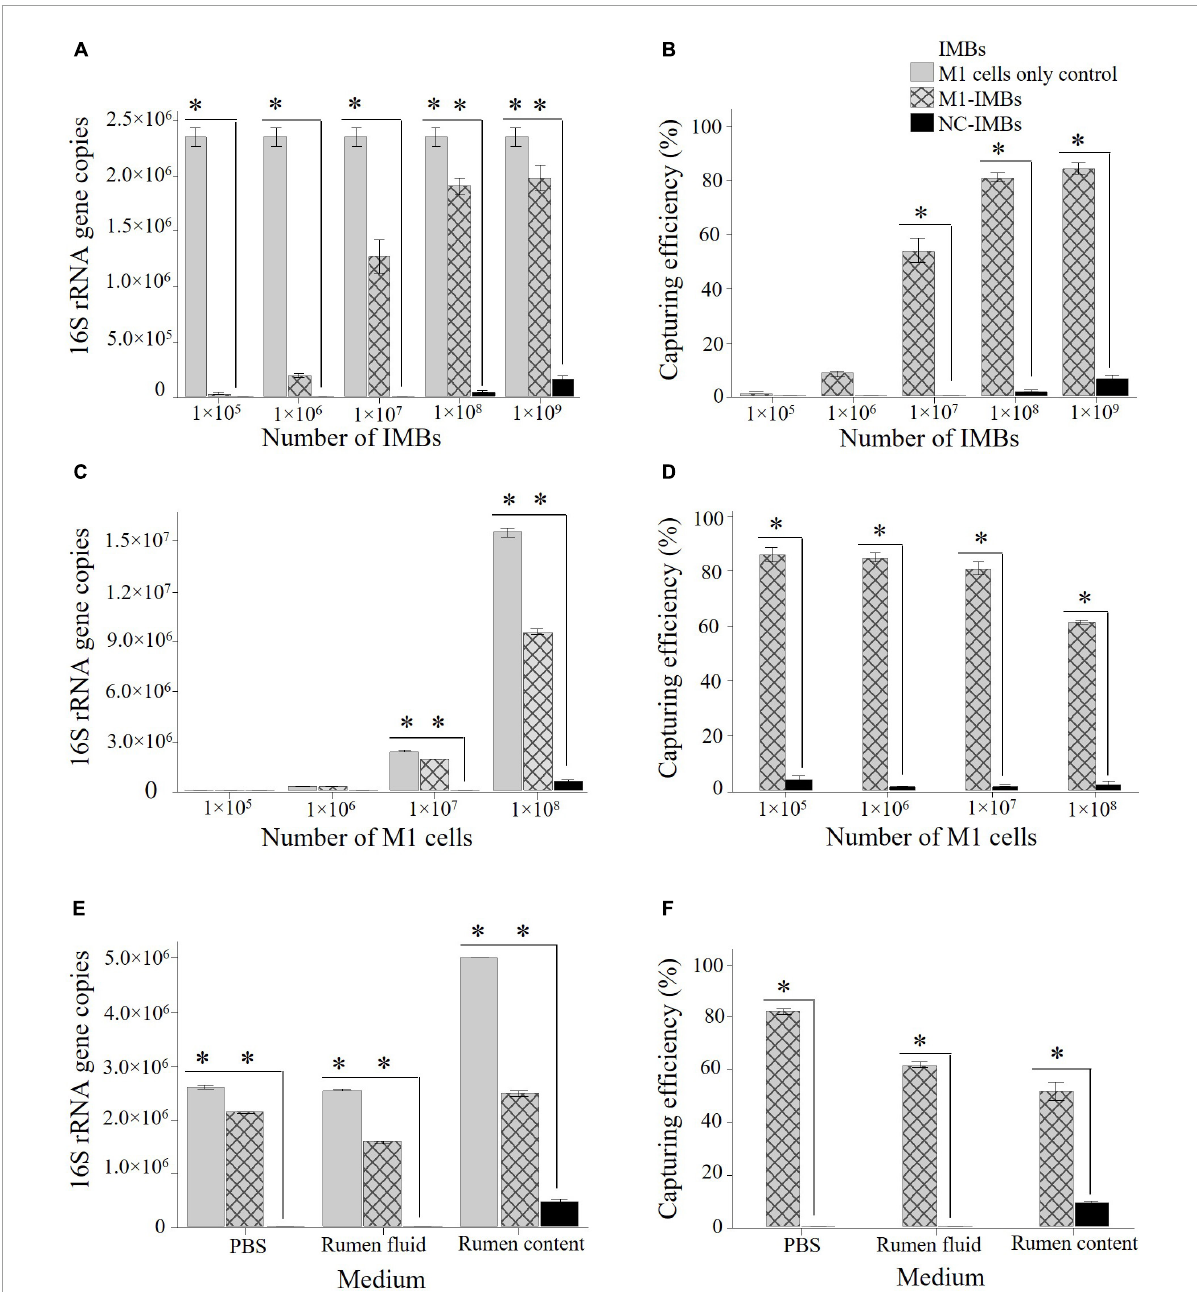
FIGURE3 Optimization of IMBs to capture M. ruminantium M1 cells. Different numbers of M1-IMBs and M1 cells were used to optimize the number of IMBs required to capture maximum number of M1 cells. Genomic DNA was isolated from captured M1 cells and quantified by qPCR using primers to amplify 16S rRNA gene. Copies of 16S rRNA gene/ µ L of sample are plotted against each dilution of M1-IMBs or M1 cells. NC-IMBs were used as a control in this experiment. Capturing efficiency was calculated on the basis of initial number of M1 cells present in the sample and defined as (methanogen cell fraction bound calculated on the basis of 16S rRNA gene copies through qPCR)/(total number of methanogen cells present in the samples) × 100. Capturing efficiency of each sample is plotted against number of M1 cells used in the assay. (A) Different numbers of M1-IMBs were used to capture 1 × 10 7 M1 cells. (B) Capturing efficiency (%) of different numbers of M1-IMBs were calculated to capture 1 × 10 7 M1 cells. (C) 1 × 10 8 M1-IMBs were used to capture different numbers of M1 cells. (D) Capturing efficiency (%) of 1 × 10 8 M1-IMBs were calculated to capture different numbers of M1 cells. (E) 1 × 10 8 M1-IMBs were used to capture 1 × 10 7 M1 cells in PBS, rumen fluid or rumen content samples. (F) Comparison of the capturing efficiency (%) of 1 × 10 8 M1-IMBs to capture 1 × 10 7 M1 cells in PBS, rumen fluid or rumen contents. Data are presented as means ( ± SE) of three technical replicates. ∗ significantly different to negative control (NC-IMBs) group ( P <